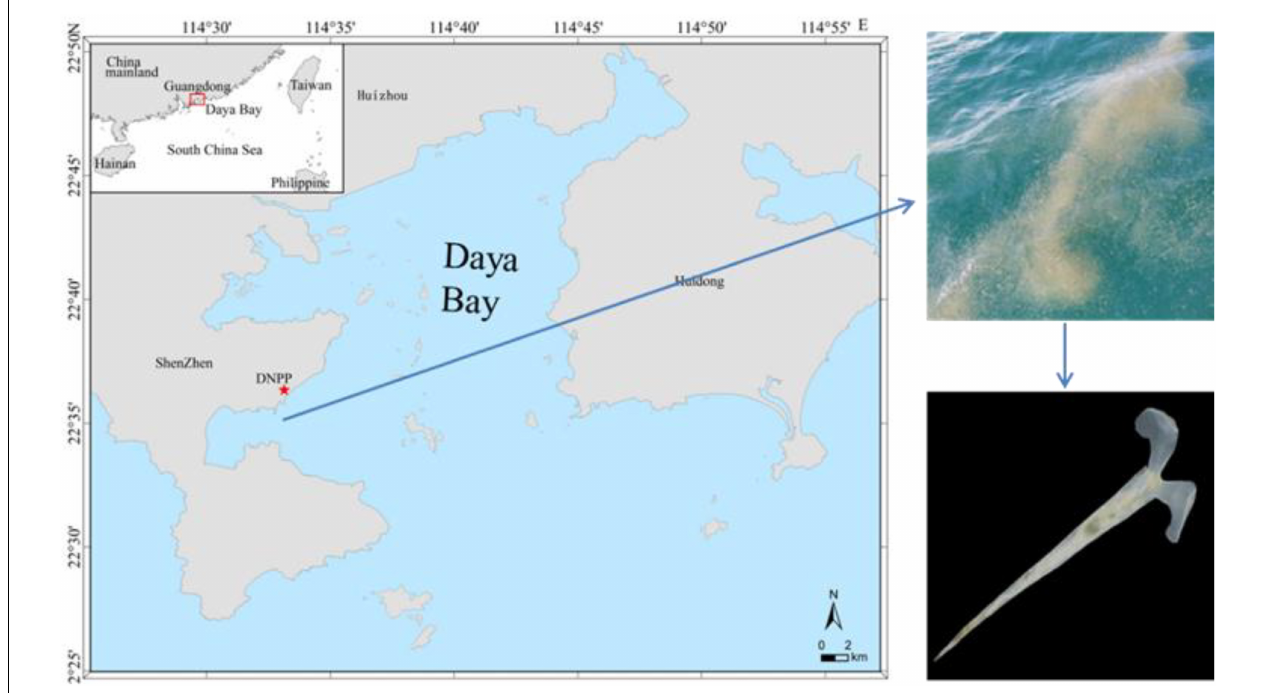
FIGURE 1 | Sampling sites of Creseis acicula nearby the Daya Bay nuclear power plant